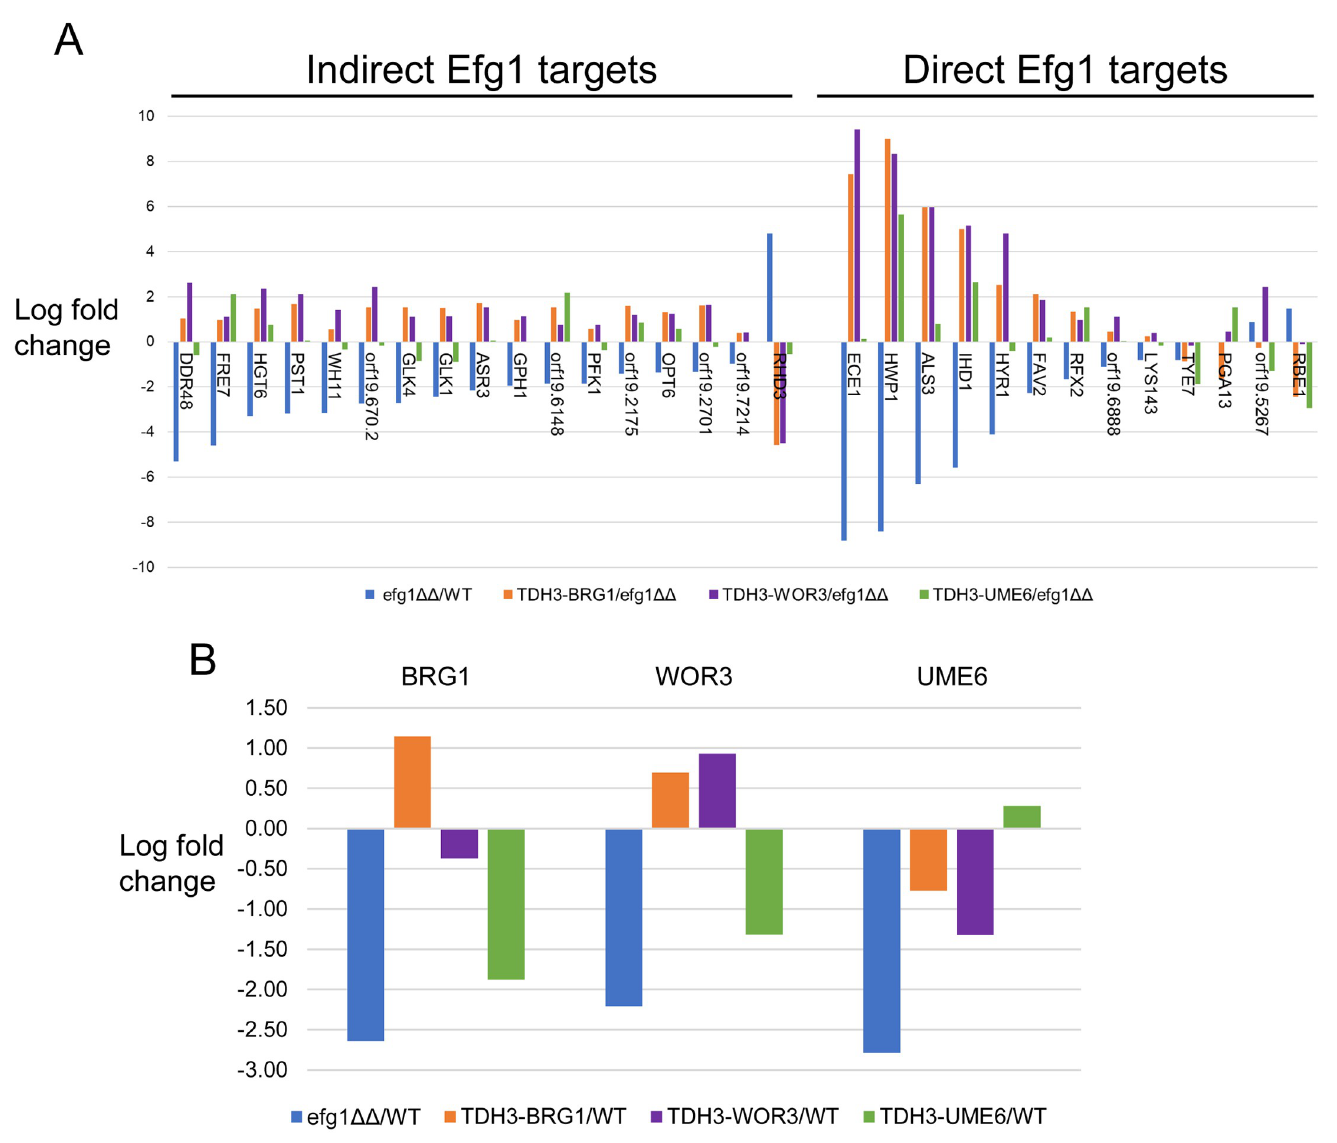
Fig 4. Panel A. Relative expression levels of selected 17-strain principal direct and indirect targets. Direct targets are genes whose 5’ regions are bound by Efg1; indirect targets are genes whose 5’ regions are not detectably bound by Efg1 [11–13]. RNA expression levels were calculated relative to the efg1 Δ / Δ for each TDH3-TF strain under strong hypha-inducing conditions (RPMI+10% FBS at 37˚C). Selected genes were those with a conserved response to a TDH3-TF mutation in the SC5314, P87, and P75010 backgrounds. Shown here are the relative expression levels for these genes in SC5314 background. Panel B. Expression levels of BRG1 , UME6 , and WOR3 relative to WT in both the efg1 Δ / Δ mutant and in each efg1 Δ / Δ TDH3-TF strain in the SC5314 isolate background. P-values for significance are given in S6